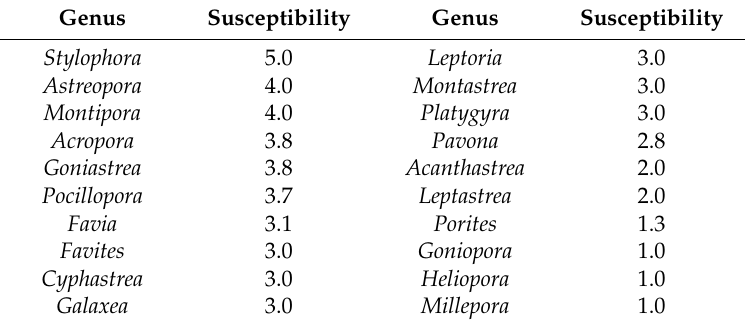
Table 1. Susceptibility of coral genera with at least 1% benthic cover in Commonwealth of the Northern Mariana Islands (CNMI) surveys, after Maynard et al. [24]—species susceptibility (1–5, low-high) averaged to genus